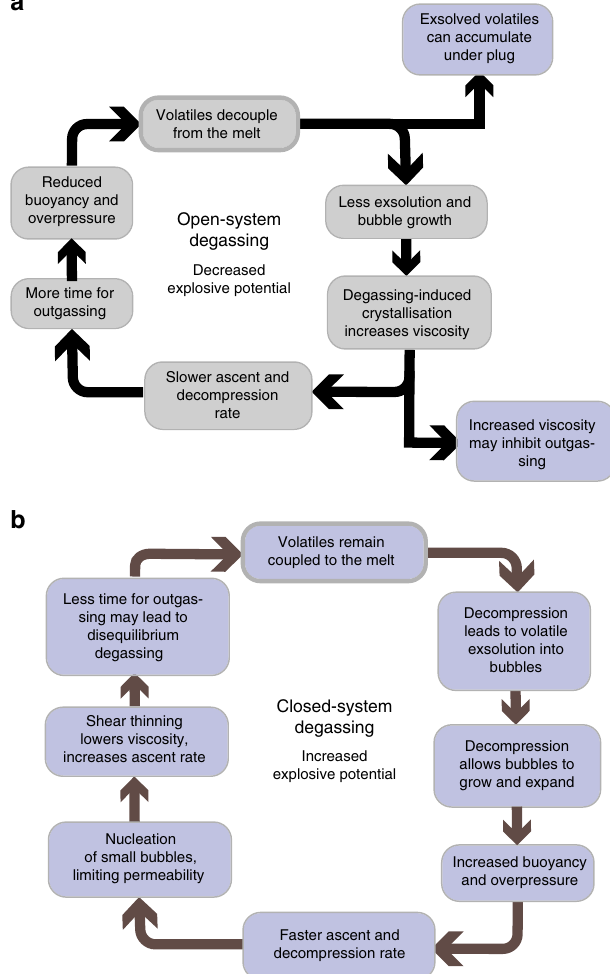
Fig. 3 Open- and closed-system degassing feedbacks have a strong control magma ascent and eruptive style. a For open-system degassing, the release of volatiles will decrease the buoyancy and overpressure of the magma, leading to slower ascent and allowing more time for equilibrium degassing and outgassing. Crystallization and viscosity increase enhance this positive feedback and left unchecked, this will normally lead to slow decompression rate, thus diminishing the likelihood of overpressure building up and leading to effusive eruptions 36,73,121 . However, negative feedbacks can also occur (purple boxes in a ), to counteract the loss of volatiles which may lead to more explosive eruptions. b The added buoyancy from volatile exsolution and bubble expansion will drive faster ascent, making outgassing less ef fi cient 179 – 181 , which may lead to disequilibrium degassing 48 . This positive feedback is further enhanced by nucleation of small bubbles, which may limit bubble coalescence 83 . In addition, for more silicic magmas or when decompression rates are high enough, decompression-induced crystallization will be suppressed 182 . This may have two effects, fi rst it keeps the viscosity low to enable faster ascent and second, it provides